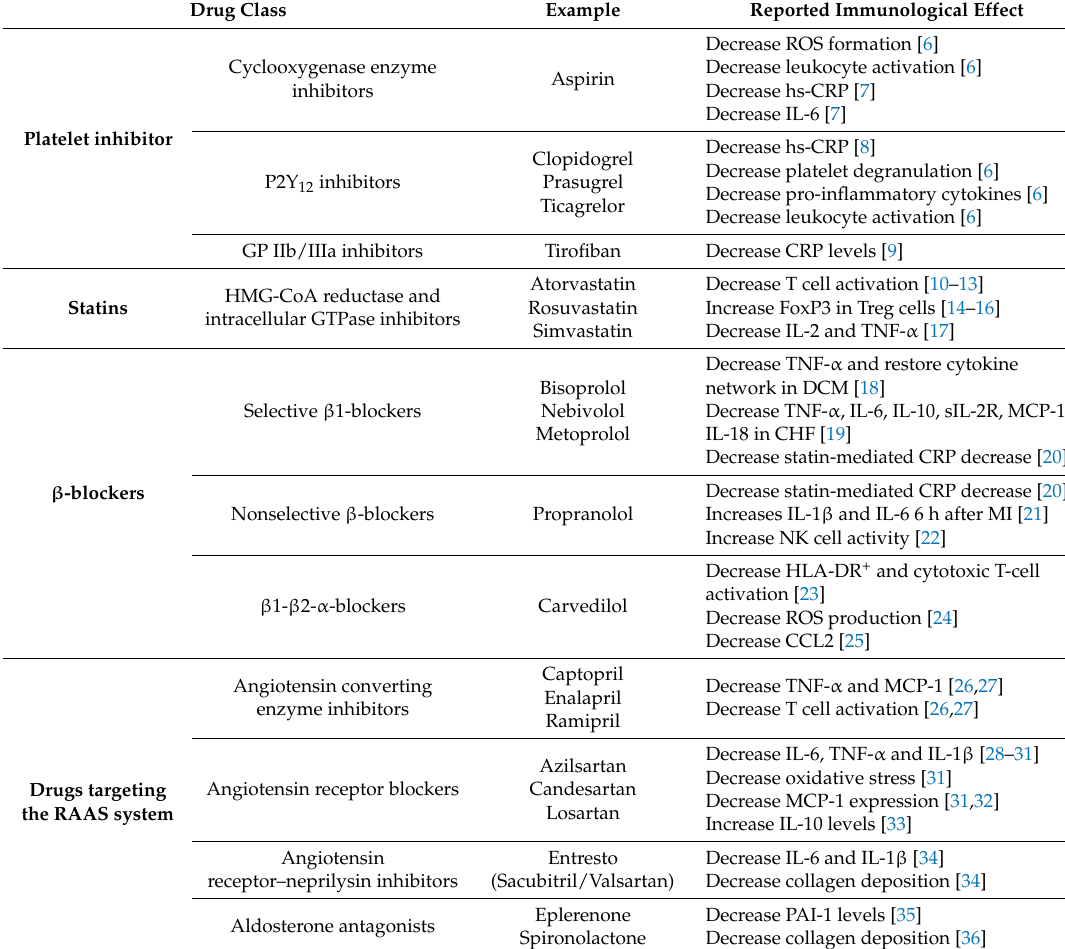
1. immunomodulatory